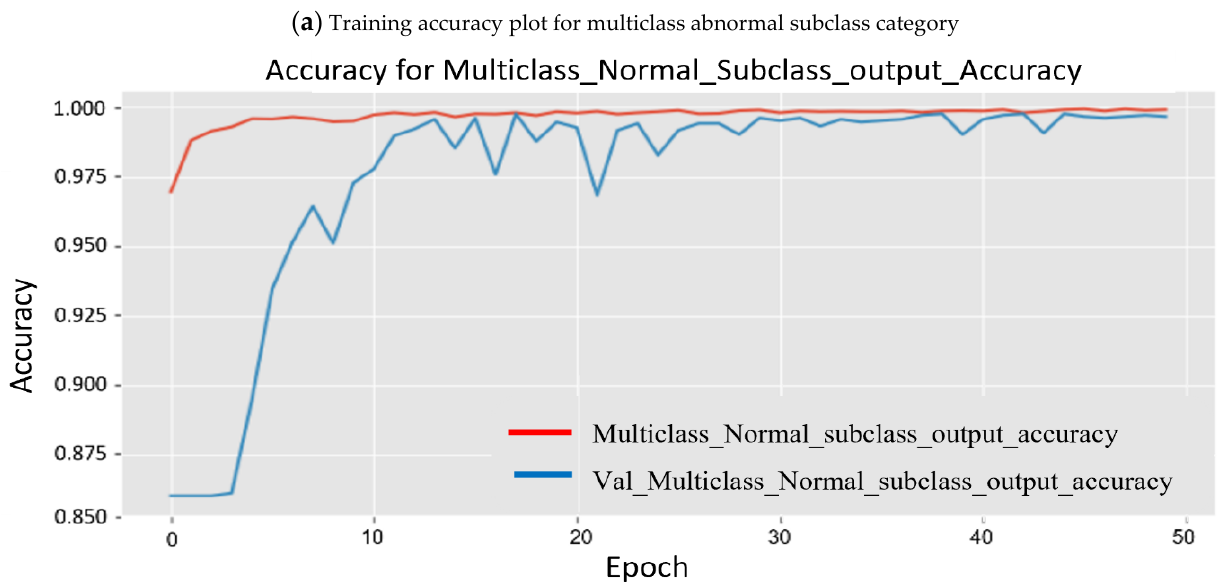
Figure 8. Two separate experimental plots show the accuracy in order to analyze the training.